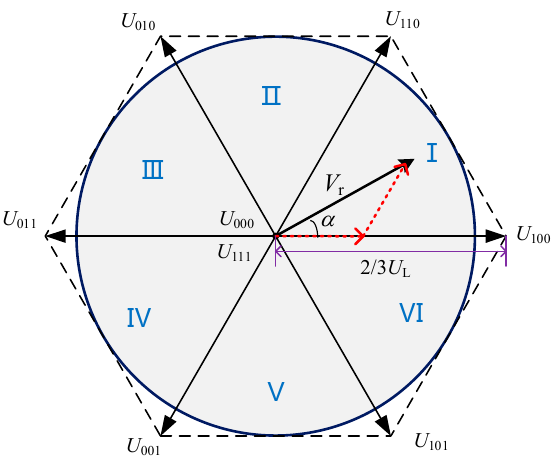
Figure 2. The modulation principle of space vector pulse width modulation (SVPWM).